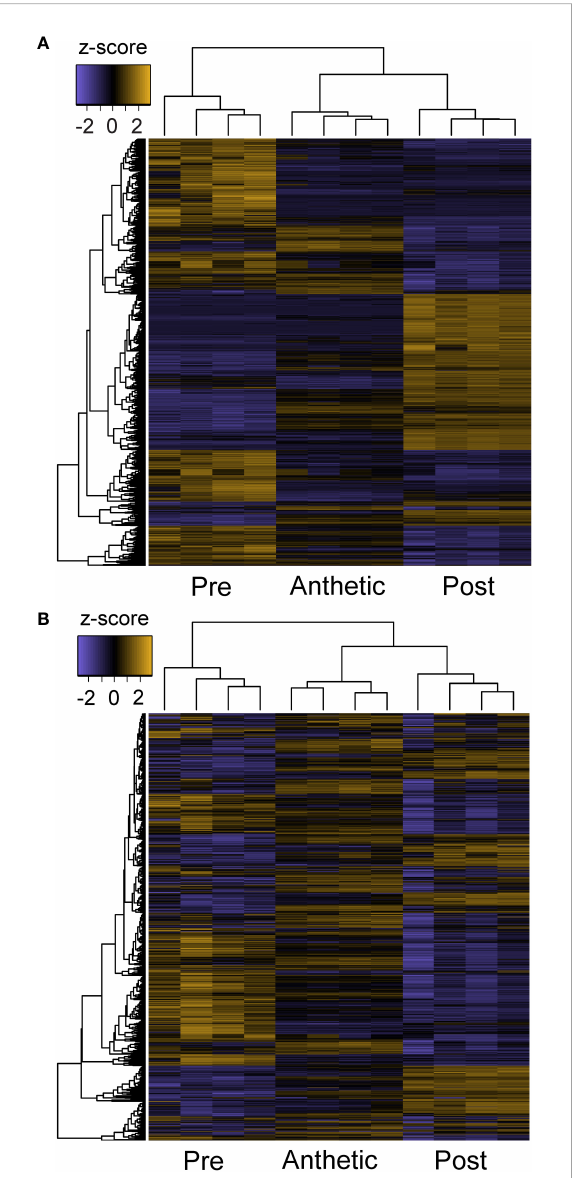
FIGURE 4 Nectar volume from Cleome violacea fl owers taken on fi rst day of anthesis (Day 1) and three days post-anthesis (Days 2, 3, and 4). Averaged value of fl owers from 20 plants. Signi fi cance measured using paired, one-tailed, student ’ s t-tests ( a <